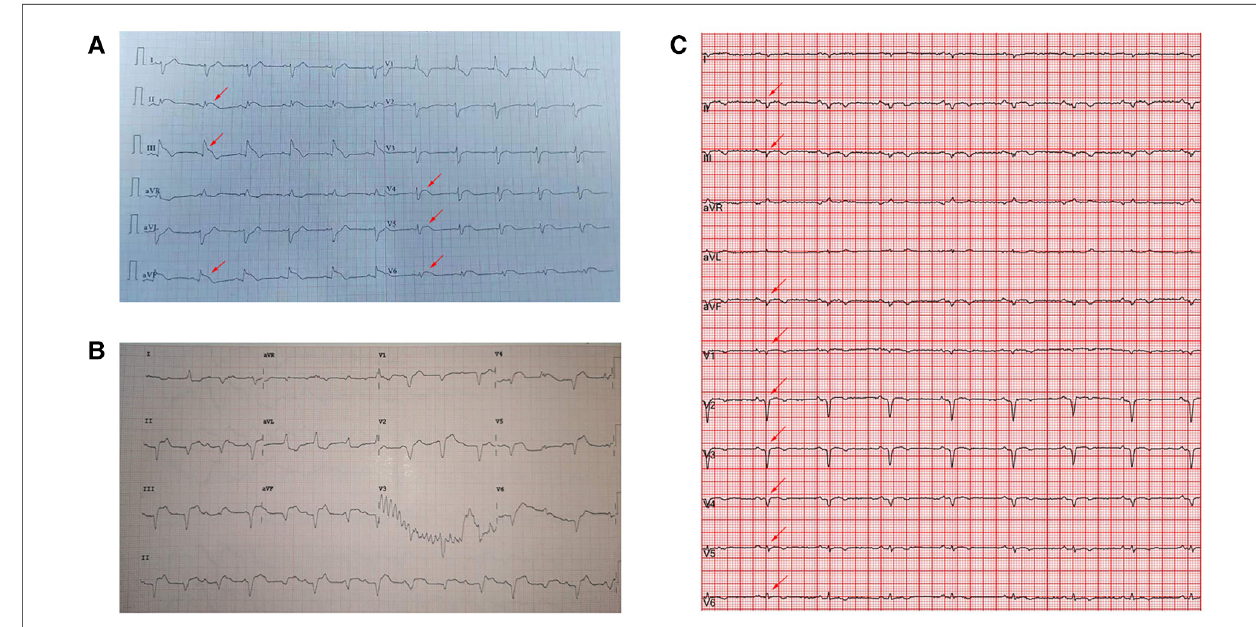
FIGURE 1 Electrocardiography showed ( A ) ST-T elevation (red arrow) in the anterolateral and inferior leads in the municipal hospital. ( B ) Type III atrioventricular block on admission. ( C ) Sinus rhythm with Q waves (red arrow) in the anterior and inferior leads on day 7 of